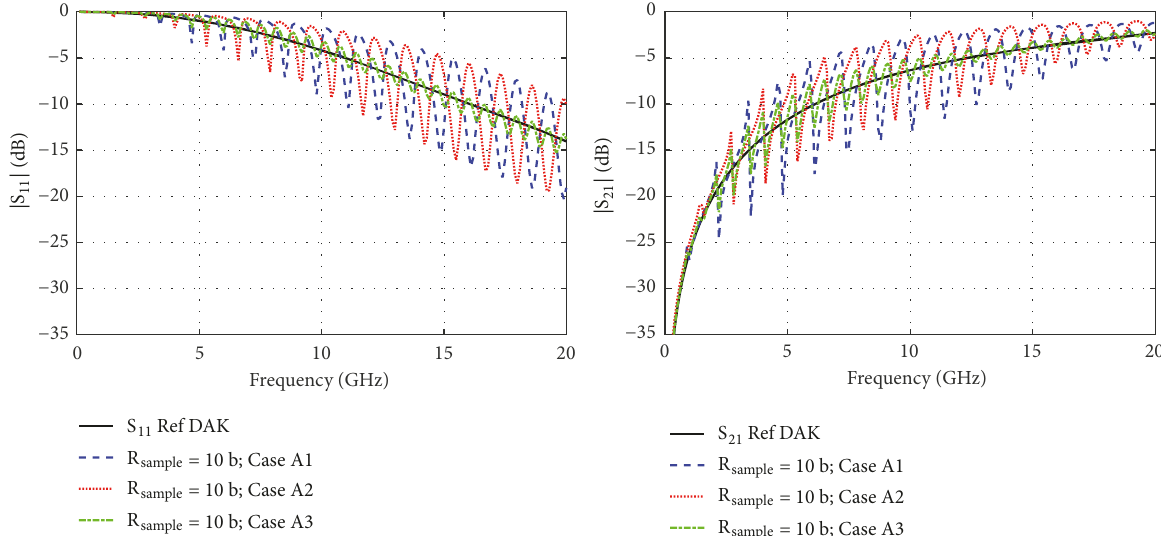
Figure 12: Magnitude (dB) of S 11 and S 21 comparing models A1, A2, and A3 with TEM and TM 0 for R =10 b and sample thickness d =1 sample